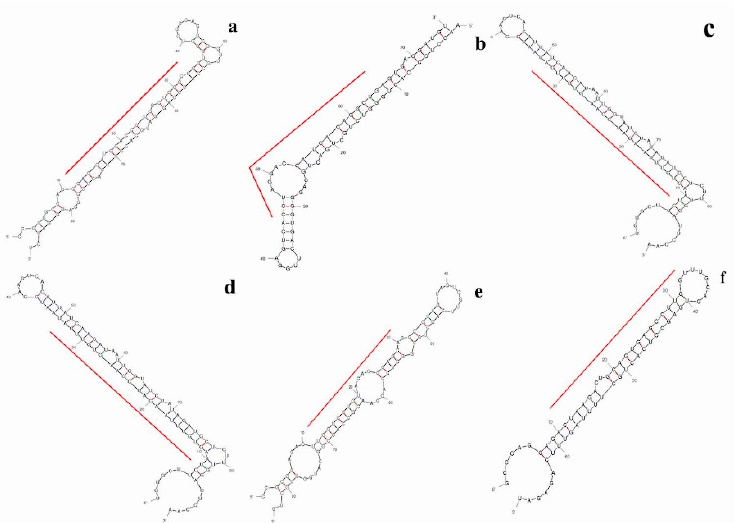
Figure 4. Predicted secondary structures of selected putative pri-miRNA sequences in the untreated control, 40, and 100 µ M EGCG treatments. The red line signifies the location of the putative mature microRNA sequence in the secondary structure. ( a ) CCAGGAUGCACGCUCGCUGGGCU; ( b ) CCUAGGACCAUCACAGGCUGA; ( c ) CAGAUGGUUGCUGAUCUGUGCA; ( d ) AGUGUUU AAGAUCCAAGUGUUG; ( e ) UUGGUGGUGUACACGGAGCAG; ( f ) CUAAGACUGCAGUGAG